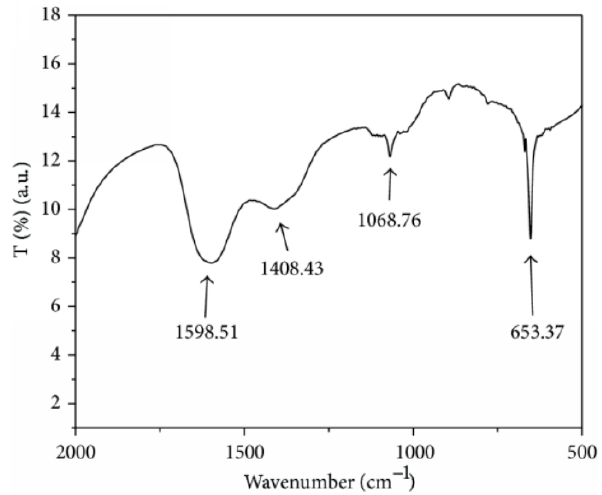
Figure 3. FTIR spectrum of the SILAR-deposited CdS reproduced with permission from [57], Hindawi, 2014.